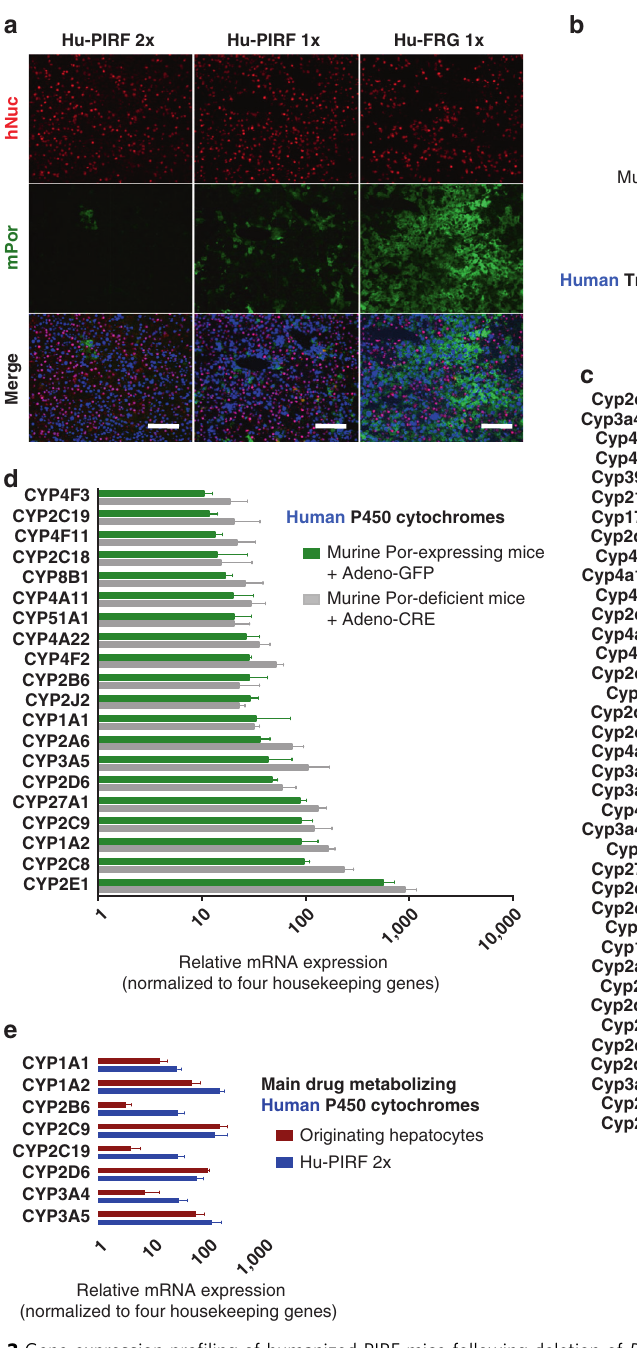
Fig. 3 Gene expression pro fi ling of humanized PIRF mice following deletion of Por . a Immunostaining of humanized PIRF and FRG mice for murine Por (mPor) and human nuclei (hNuc) after injection of Adeno-Cre (2.2 × 10 10 pfu/mouse) once (1x) or twice (2x). Counterstaining in merged picture using DAPI. b Experimental outline for murine and human transcriptomics from chimeric livers with or without Por deletion. Chimeric mice ( N = 7) injected with either Adeno-Cre or Adeno-GFP (2.2 × 10 10 pfu/mouse) were euthanized after 1 week and liver tissue from all seven lobes was analyzed. Comparison of murine c and human d cytochromes originating from the same chimeric livers. e Gene expression of the main drug metabolizing human cytochromes in humanized, Por -deleted PIRF (Hu-PIRF 2x) mice and originating isogenic human hepatocytes ( N = 2 donor hepatocytes and 4 isogenic humanized mice). Gene expression has been normalized to four human housekeeping genes and their murine counterparts ( PSMB2 , PSMB4 , RAB7A , and VPS29 ; Psmb2 , Psmb4 , Rab7 , and Vps29 ) 54 . Mean with range are given in c – e . FRG, Fah − / − /Rag2 − / − /Il2rg − / − ; PIRF, Por c/c /Il2rg − / − /Rag2 − / − /Fah − /